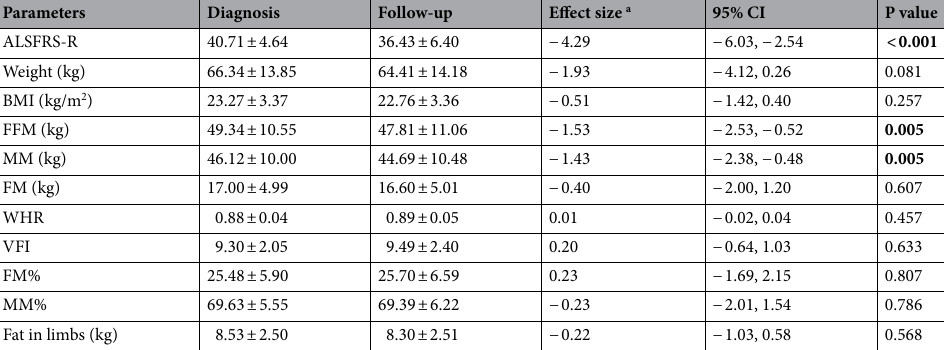
Table 3. Comparison of nutritional parameters at diagnosis and follow-up in patients (n = 21). a Mean difference. ALSFRS-R revised ALS Functional Rating Scale, BMI Body Mass Index, FFM fat-free mass, MM muscle mass, FM fat mass, WHR waist hip rate, VFI visceral fat index, FM% proportion of fat mass, MM% proportion of muscle mass. P-value < 0.05 is shown in